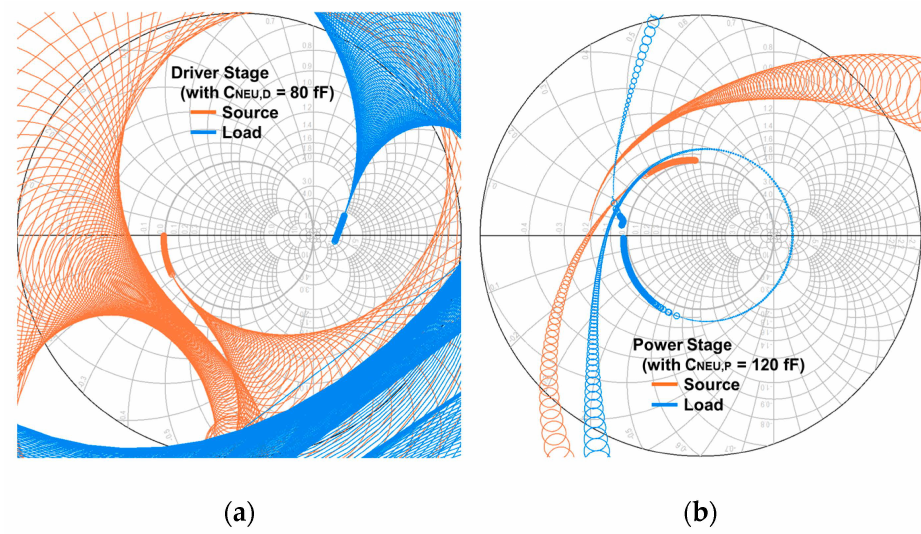
Figure 5. Simulated stability circles with selected neutralization capacitors: ( a ) driver and ( b ) power stages.